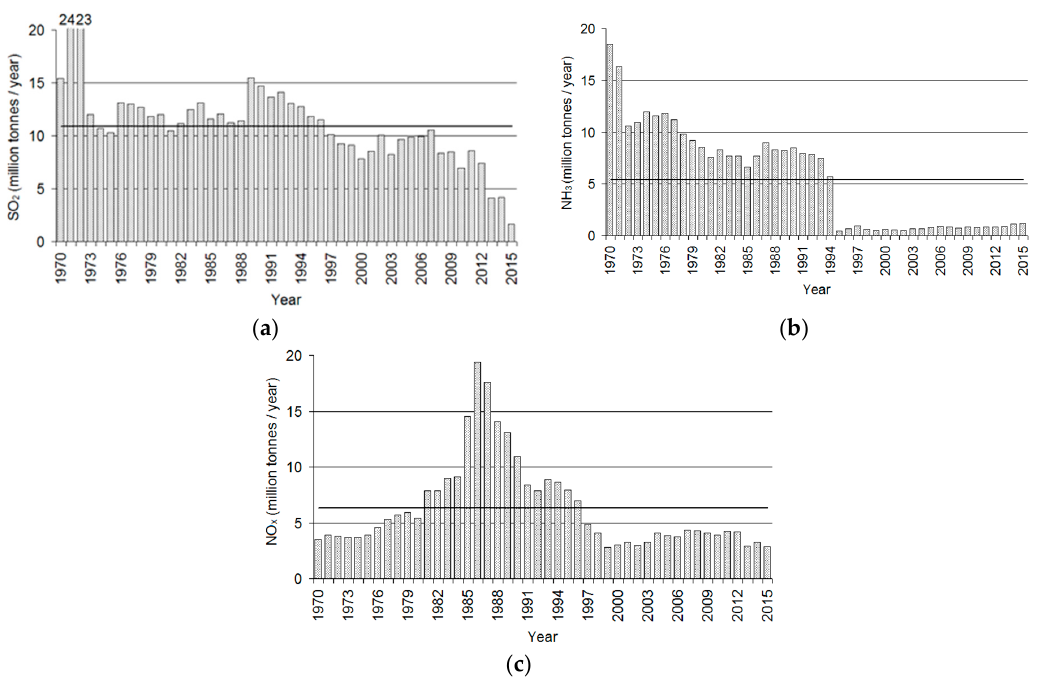
Figure 3. Emission of gaseous pollutants SO 2 ( a ), NH 3 ( b ), NO x ( c ) from emitters of Zak ł ady Azotowe Pu ł awy 1970–2015.